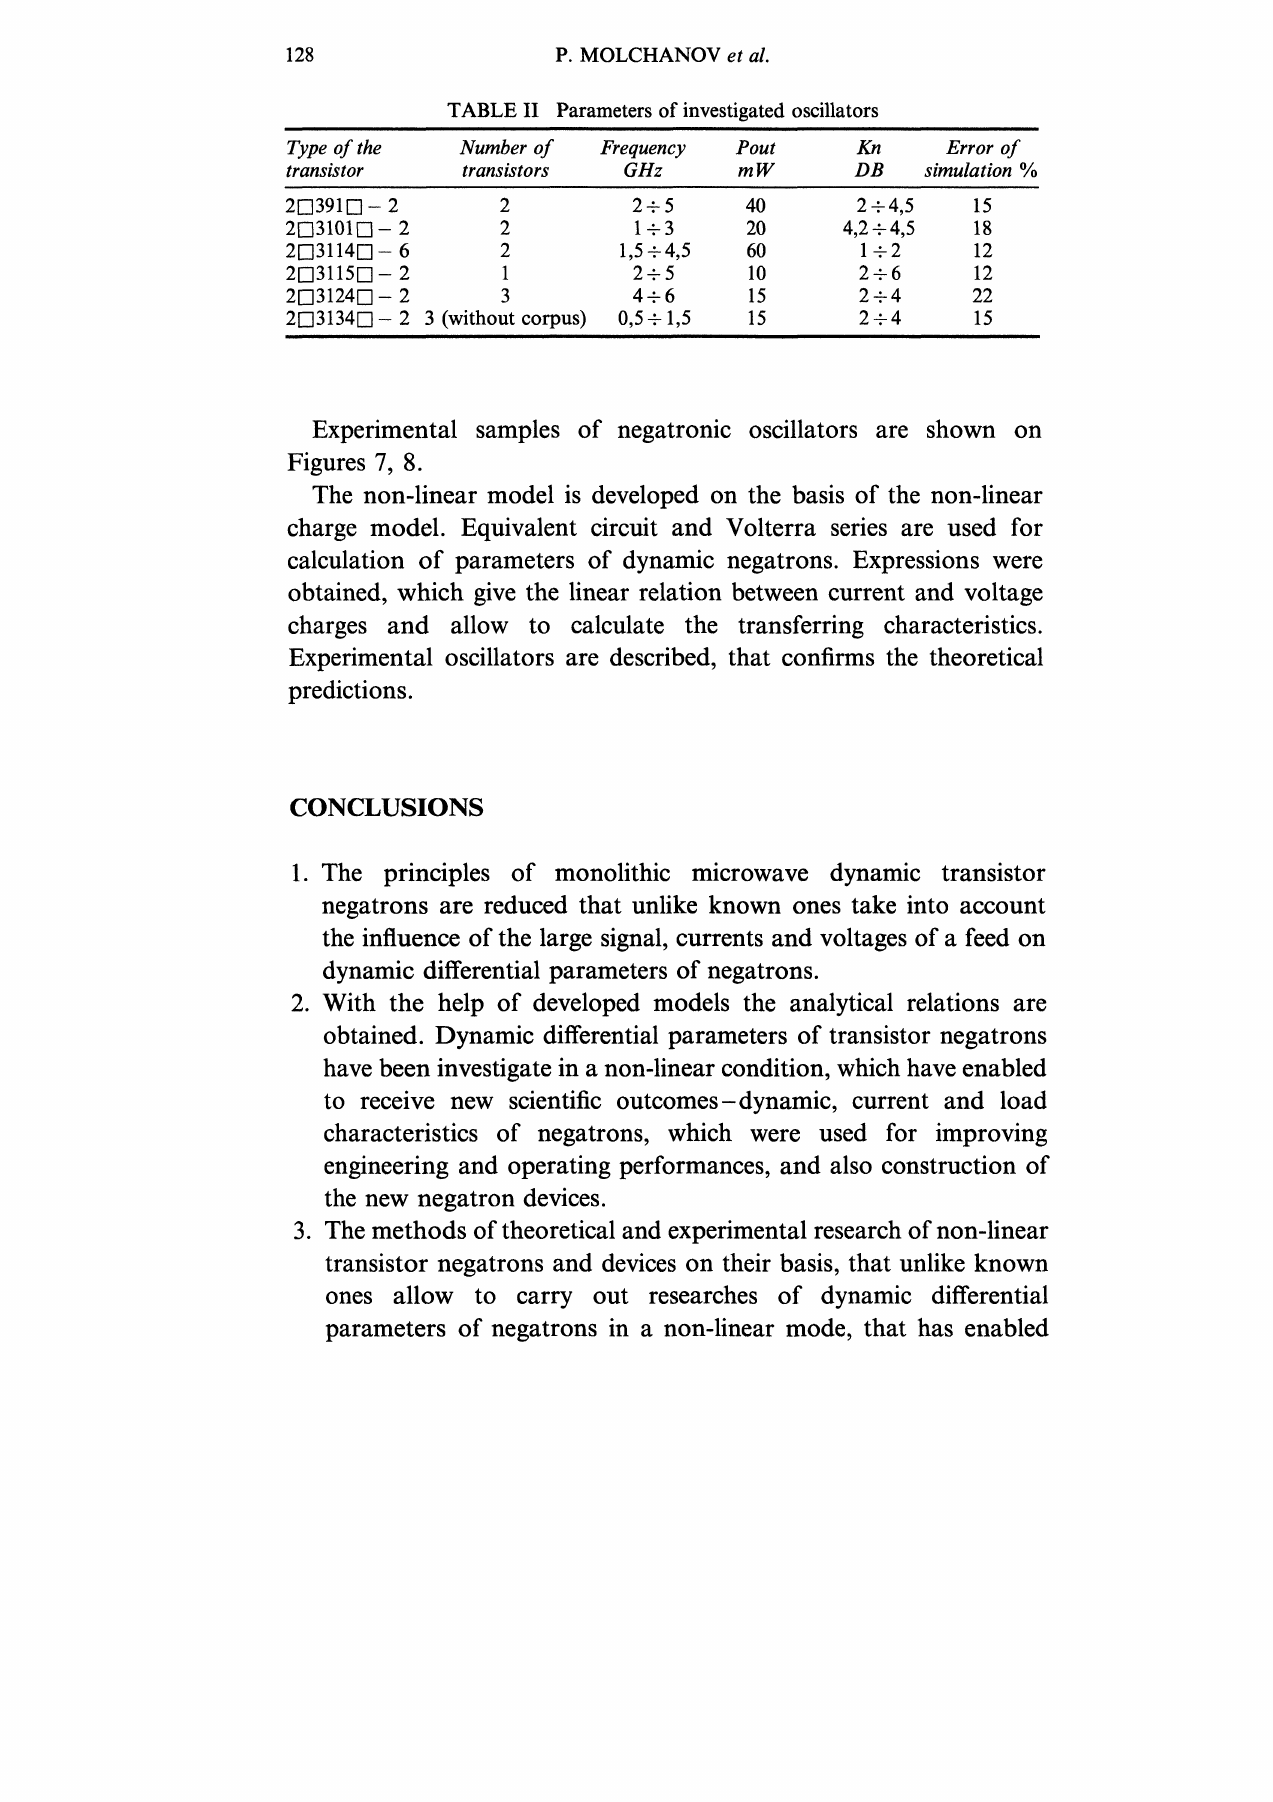
TABLE II Parameters of investigated